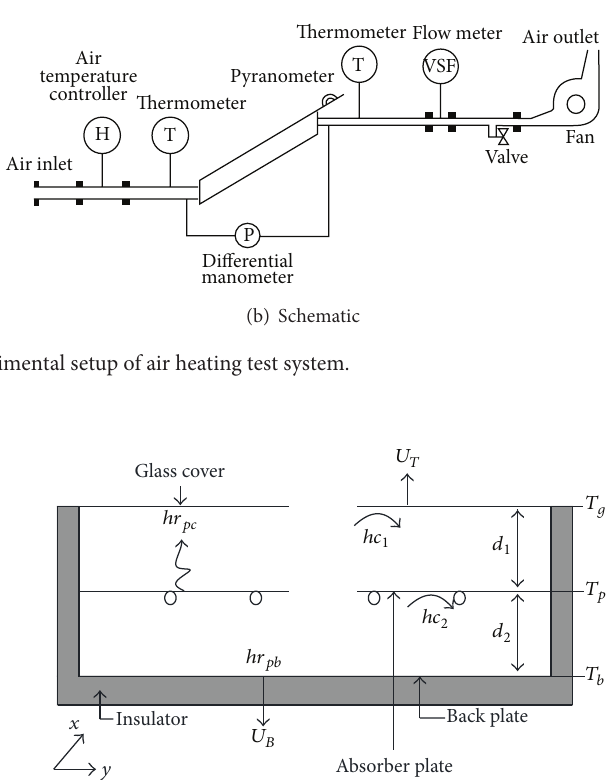
direction to water tubes. In the following, energy balance equations are given for the components of DFSC including the glass cover, absorber plate, copper tubes, backboard, and the water flow in